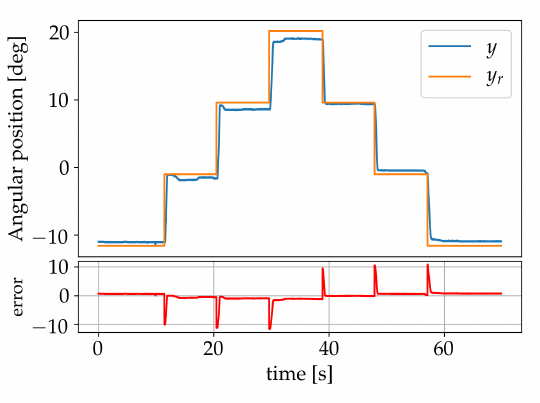
Figure 12. Results after learning using